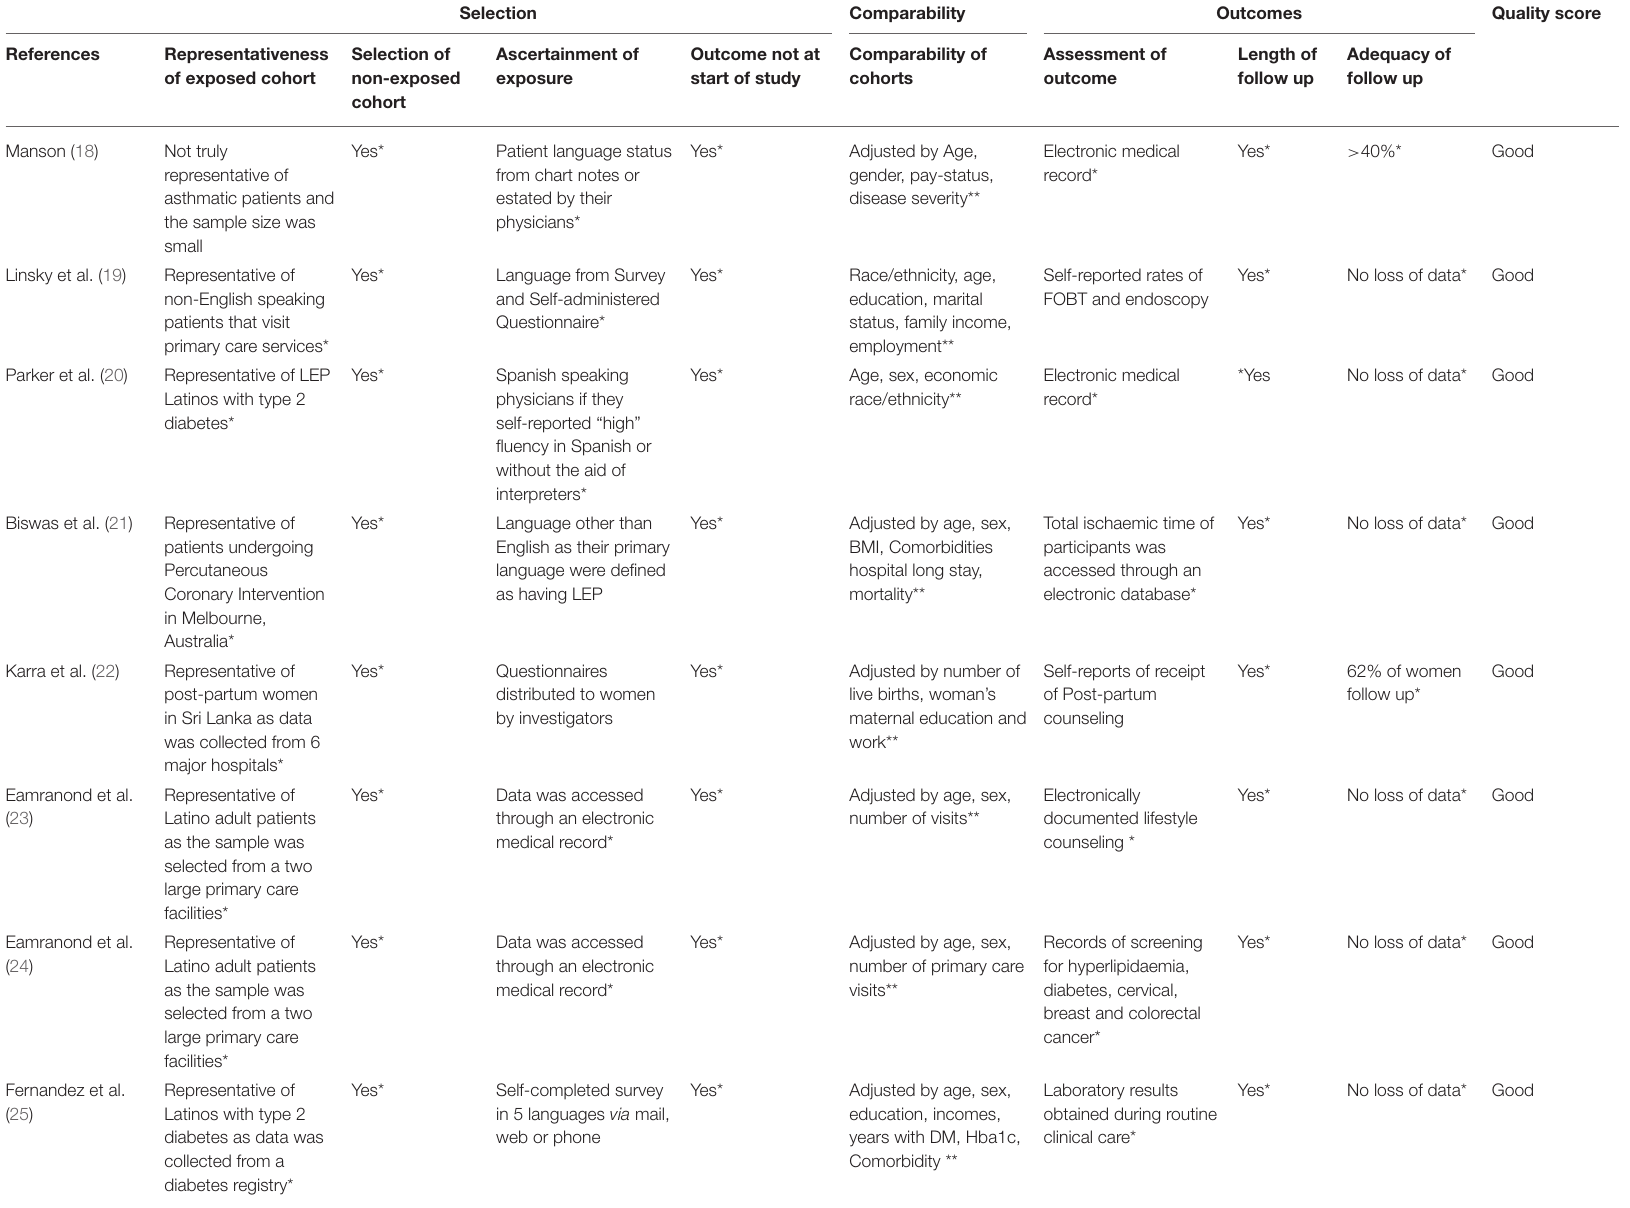
TABLE 2 | Quality assessment (modified Newcastle-Ottawa Assessment